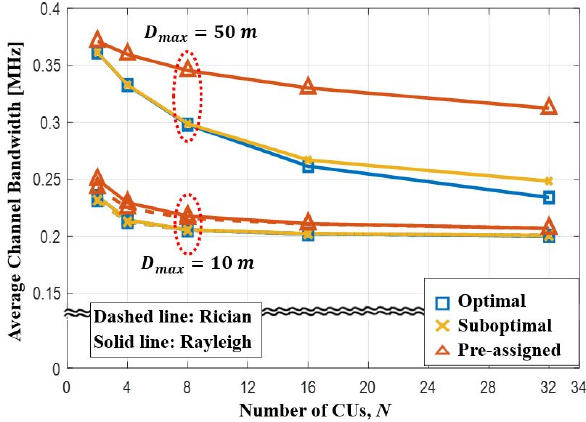
Figure 4. Average channel bandwidth vs. the number of CUs, N.